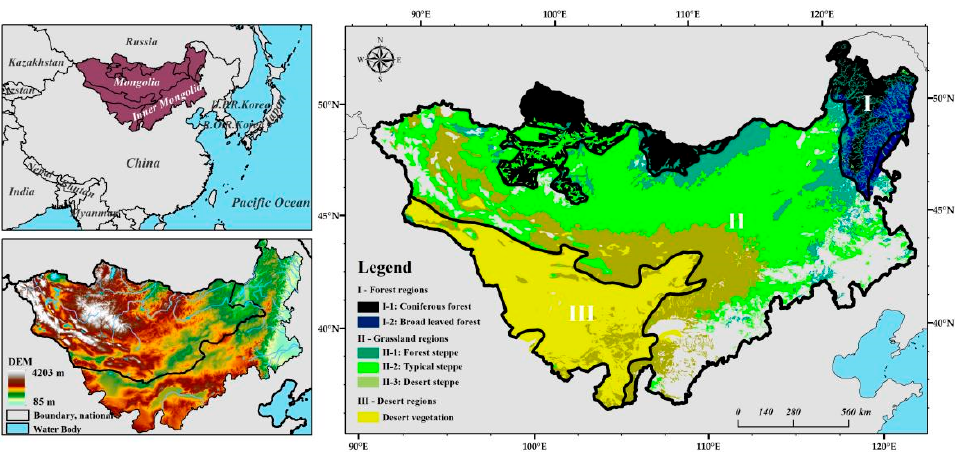
Figure 1. Locations of the Mongolian Plateau (MP), elevation, and vegetation types.